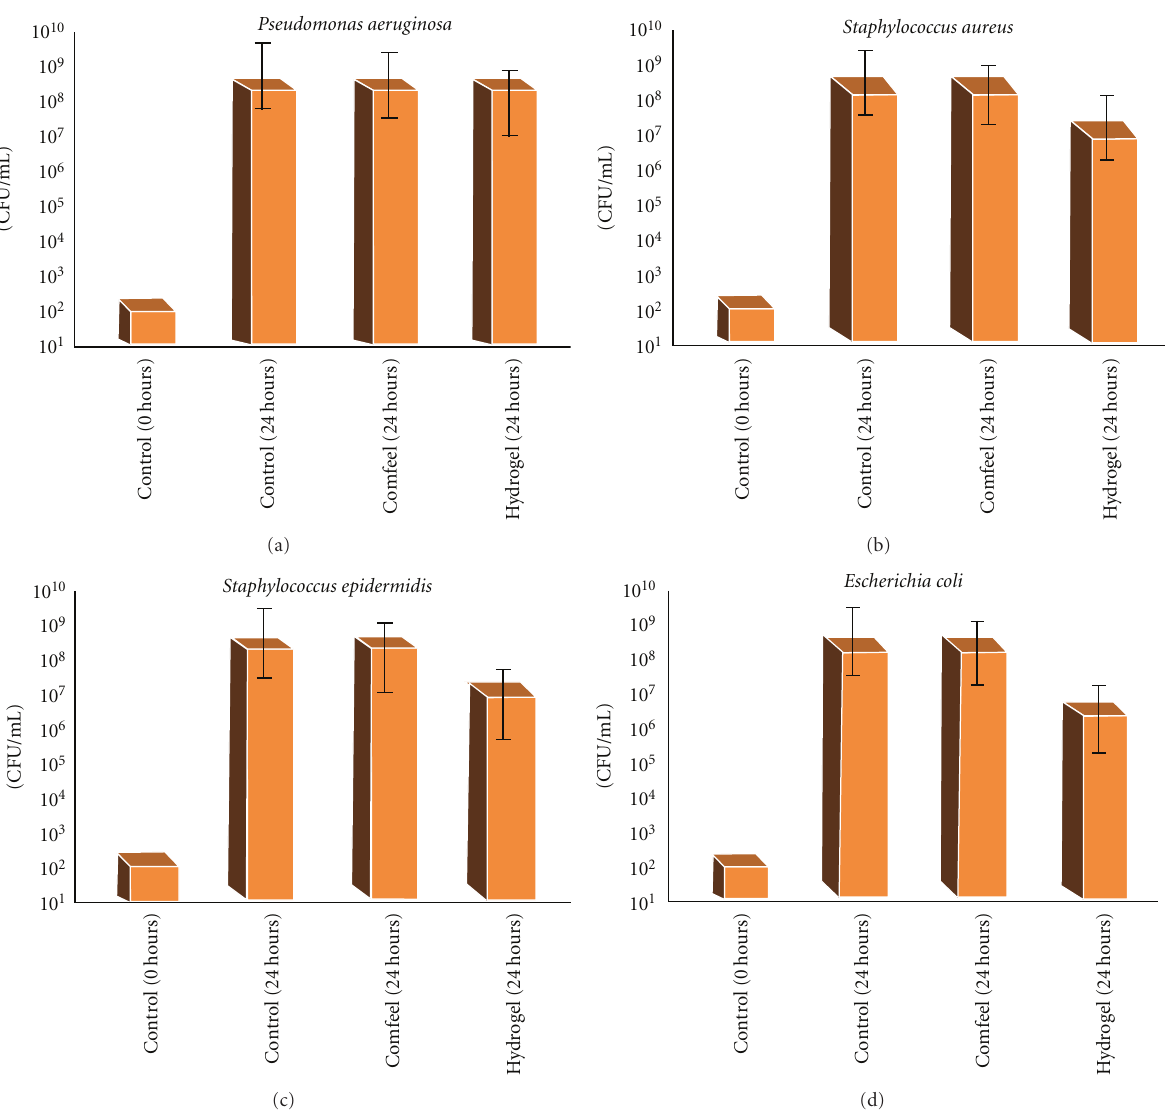
Figure 3: The number of microorganisms, control (a) after 0 hours, control (b) after 24 hours, comfeel (c) after 24 hours, and hydrogel (d) after 24 hours.